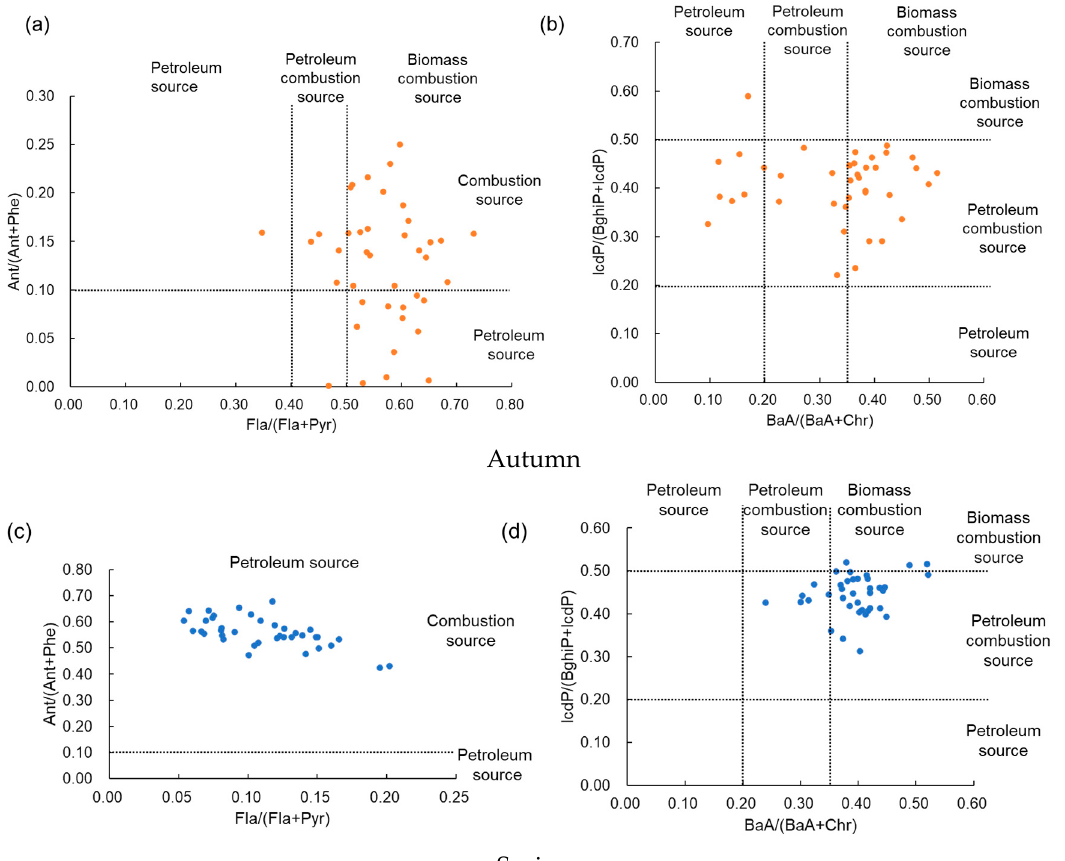
Figure 6. Diagnostic ratios of PAHs in the farmland near the highway in different seasons. ( a , b ) Autumn and ( c , d ) spring.